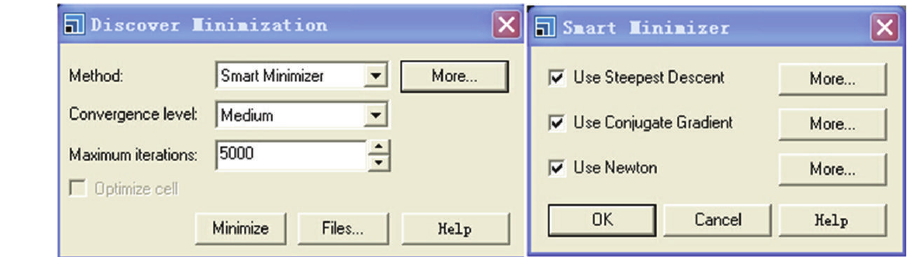
Figure 3: The details of the simulation parameters for minimization.